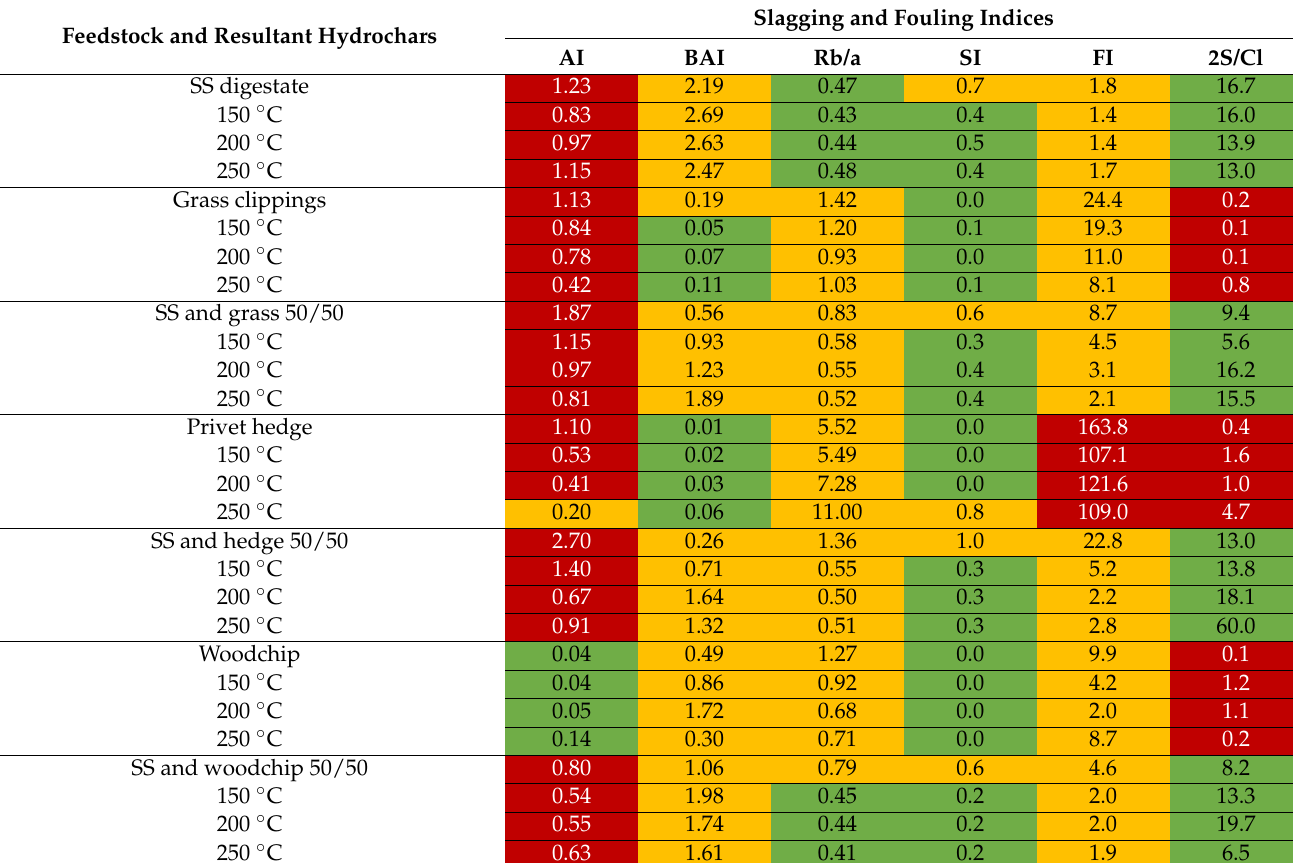
Table 6. Slagging and fouling indices for hydrochar from SS digestate, lignocellulosic biomass, and 50/50